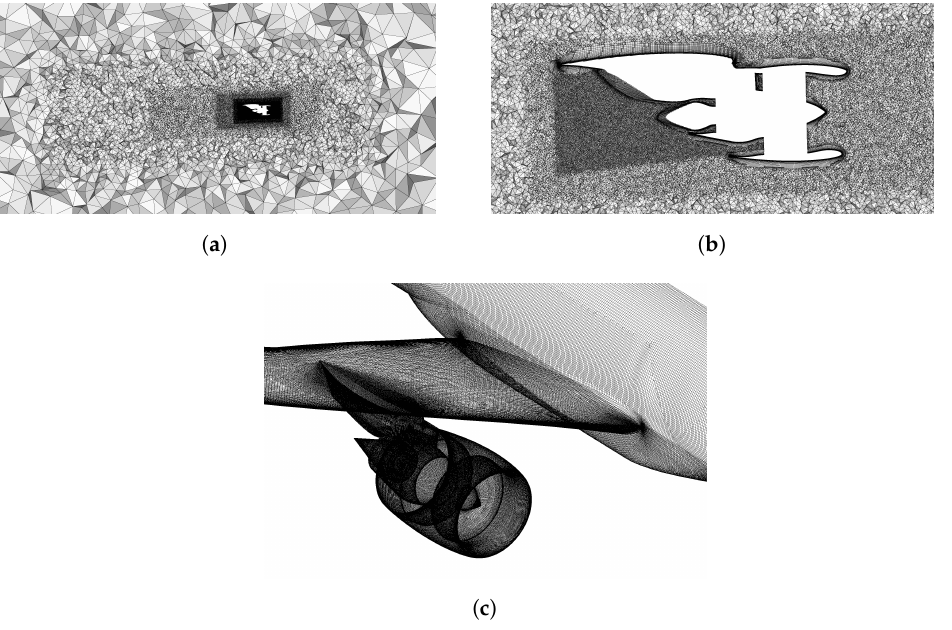
Figure 1. Different views of a sample mesh. ( a ) Multiple refinement blocks to better resolve the flow around the powered-on nacelle. ( b ) Detail of the mesh around the nacelle with the wall-normal grown boundary layer. ( c ) Surface mesh on the model walls. Table 1. Grid convergence analysis at